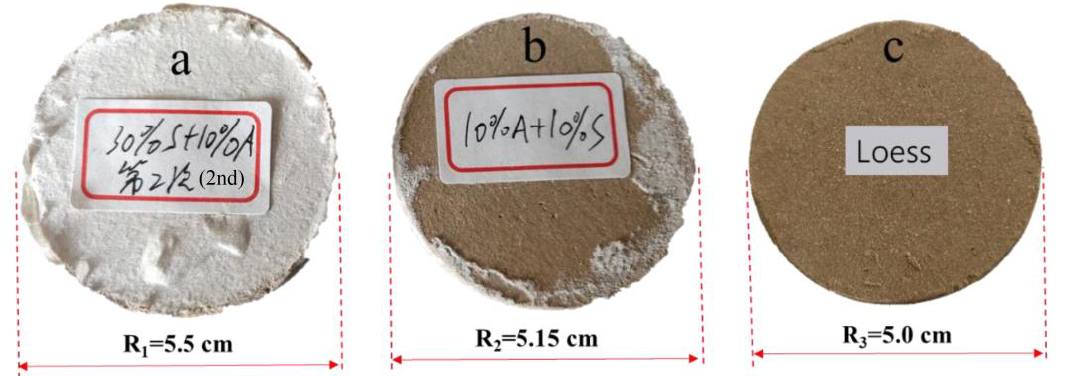
Figure 5. Change of specimen section diameter. ( a ) Attapulgite-Lime modified loess, ( b ) Attapulgite- Cement modified loess, ( c ) Loess.